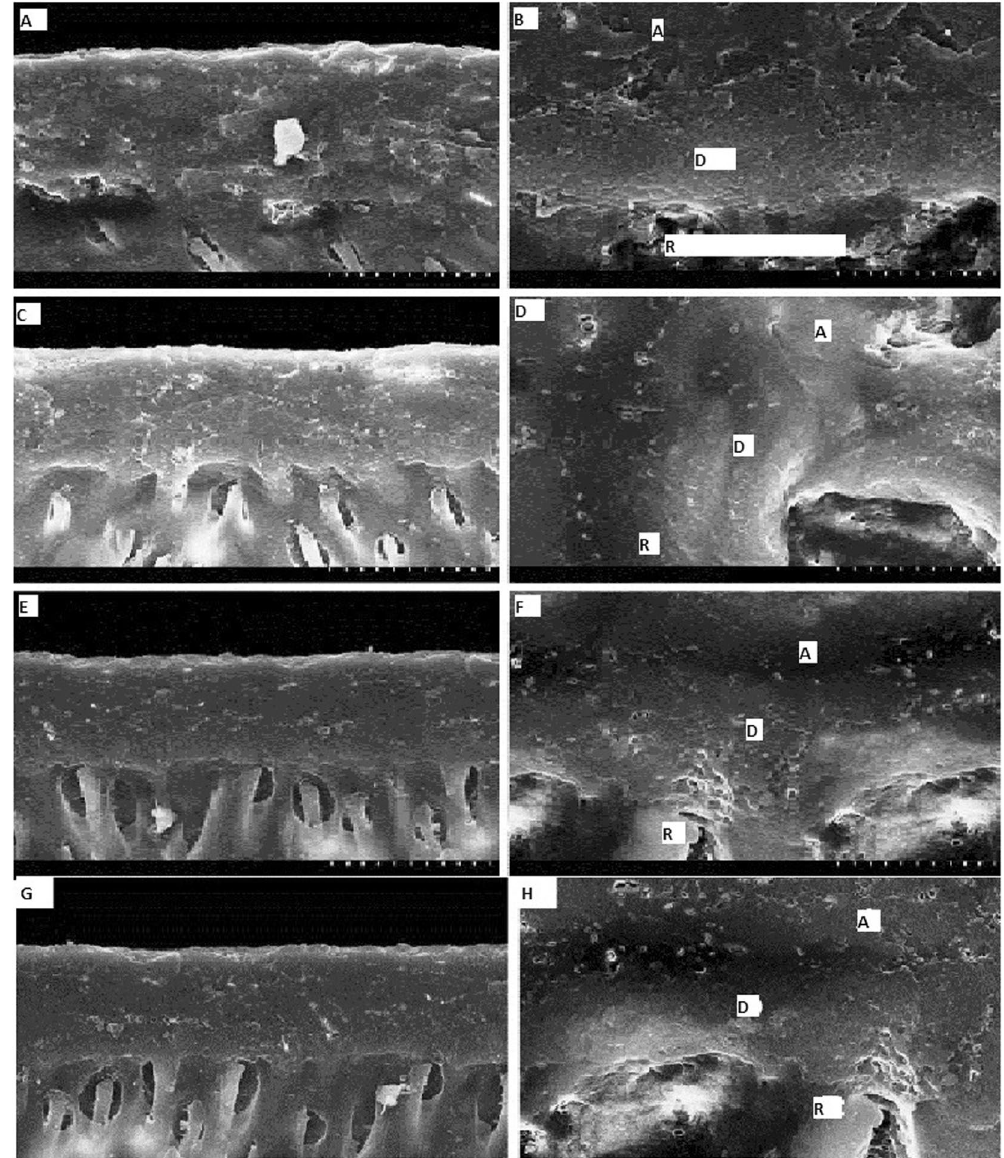
Figure 2. Cross Sectional Images of the Dentin Hybrid Layer after the Adhesion (R: Resin Tages, D: Dentin, A: Adhesive). ( A ) COA images: DHL layer has been depicted where exposed collagen fibers marked by gold nanoparticles. ( B ) Amplification of COA images: Exposed collagen fibers at the bottom of the DHL can be clearly seen. ( C ) CHA images: DHL is more uniform, constant and maximum dense, very high density regions are visible at the bottom of DHL where exposed collagen fibers are indicated by gold nanoparticles. ( D ) Amplification of CHA images: Exposed collagen fibers at the bottom of the DHL can be seen. ( E ) DOA images: DHL is more uniform and dense, no boundary between the bonding agent layer and the hybrid layer, high density regions are less visible at the bottom of the hybrid layer where exposed collagen fibers are indicated by gold nanoparticles. ( F ) Amplification of DOA images: Exposed collagen fibers at the bottom of the DHL can be seen. ( G ) PAA images: DHL layer has been depicted where exposed collagen fibers marked by gold nanoparticles. ( H ) Amplification of PAA images: Exposed collagen fibers at the bottom of the DHL can be clearly